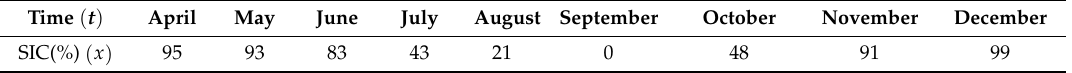
Table 1. Samples of monthly sea ice concentration (SIC) values.